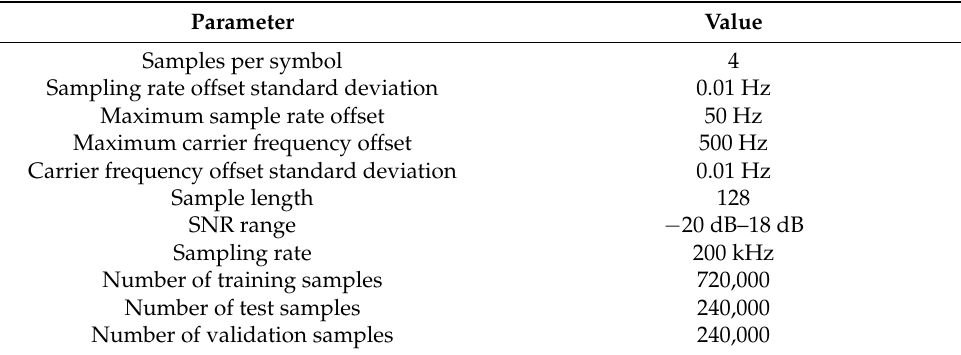
Table 1. RadioML2016b dataset parameter